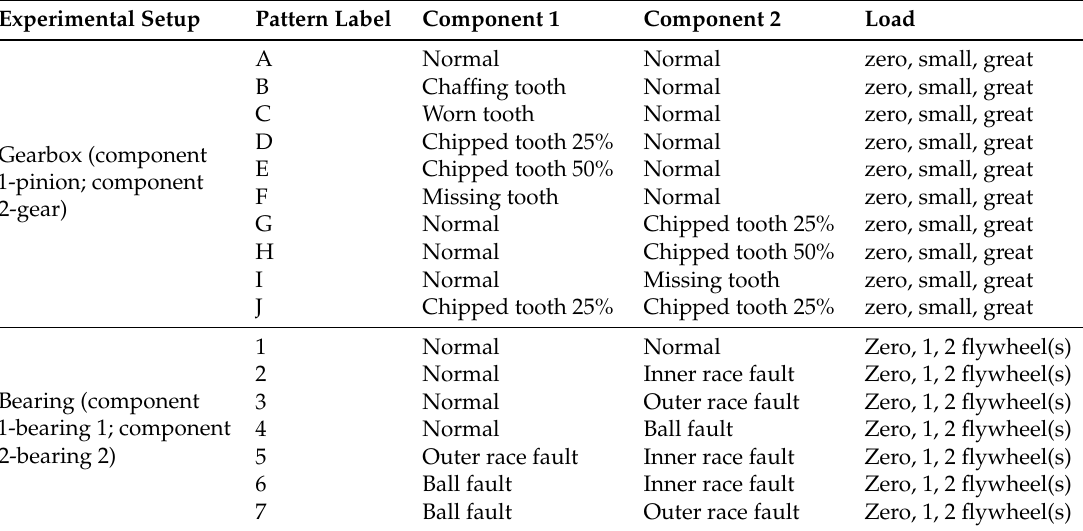
Table 1. Experimental configurations of different condition